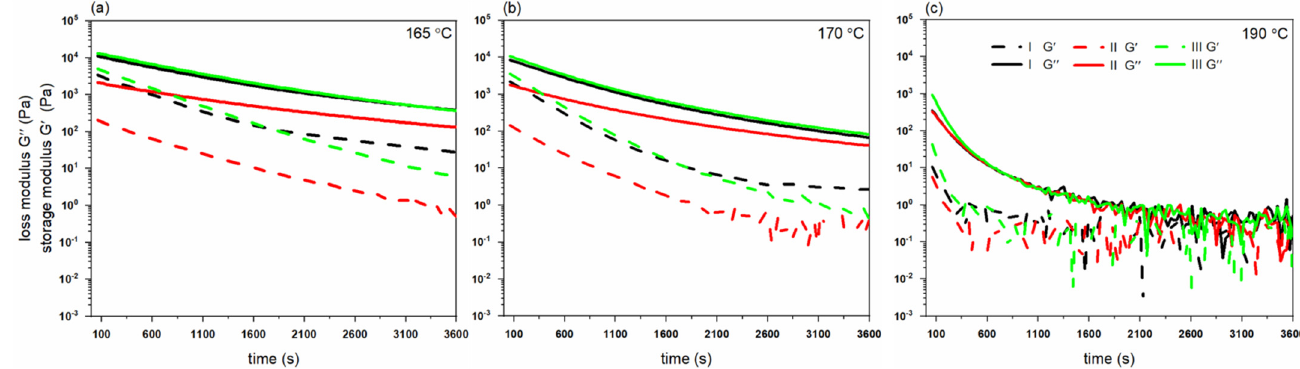
Figure 5. Change in loss (G ″ ) and storage modulus (G ′ ) of PHBH polymer grades at ( a ) 165, ( b ) 170 and ( c ) 190 °C.